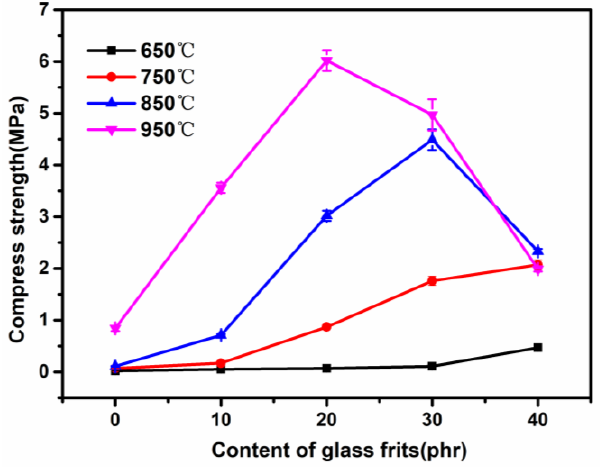
Figure 6. Volume variations in the residues of micromorphology at different temperature of silicone composites.